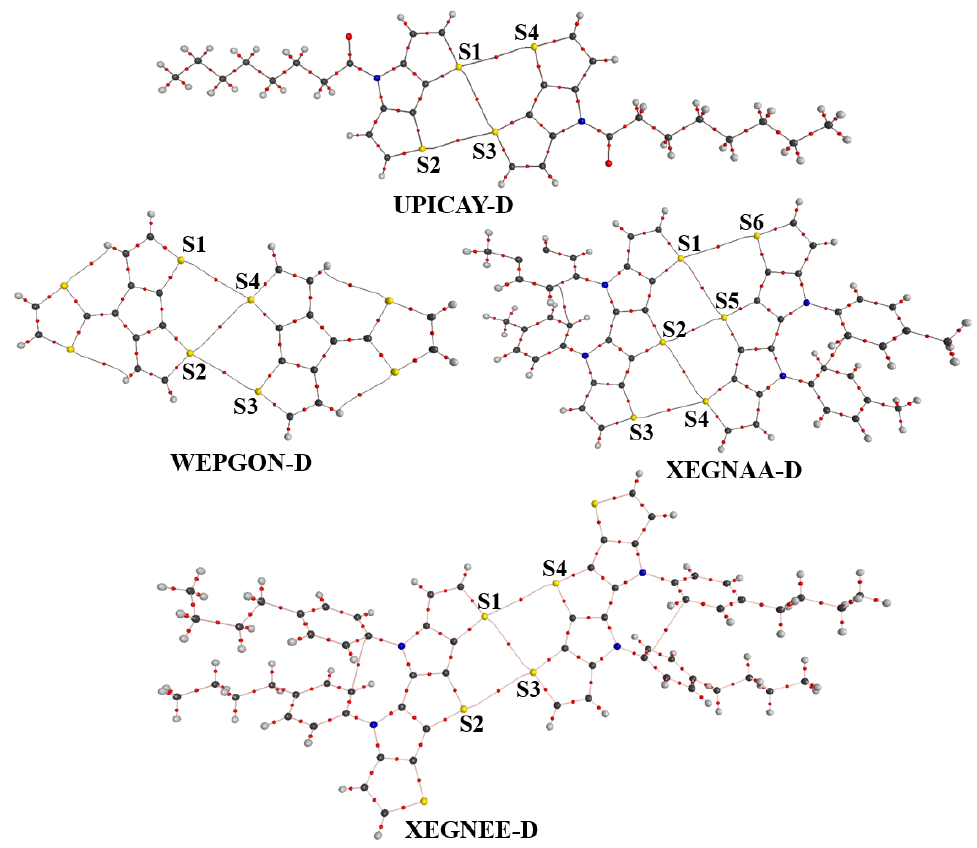
Figure 6. The bond paths and bond critical points (small red dots) of the dimers UPICAY-D, WEPGON-D, XEGNAA-D and XEGNEE-D. Table 3. The electron densities ( ρ ), electron density Laplacians ( (cid:53) 2 ρ ), eigenvalues of the Hessian matrix ( λ 1 , λ 2 , λ 3 ) and ellipticities ( ε ) at the bond critical points of the S ··· S contacts in the dimers studied. Atomic units are used for these